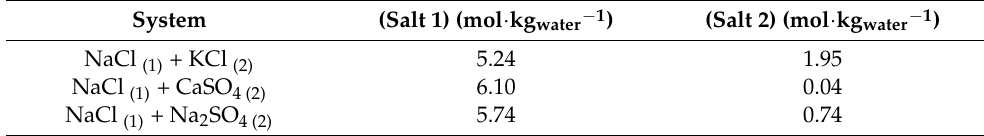
Figure 1. Phase diagrams for the aqueous ternary system at 25 ◦ C: ( A ) NaCl–KCl; ( B ) NaCl–CaSO 4 ; and ( C ) NaCl–Na 2 SO 4 . The three systems have eutonic points—where the two solubility lines meet—and the respective solid phases and solution are in equilibrium. The eutonic concentration for each system is shown in Table 1. Table 1. Eutonic concentrations of the studied systems at 25 °C.